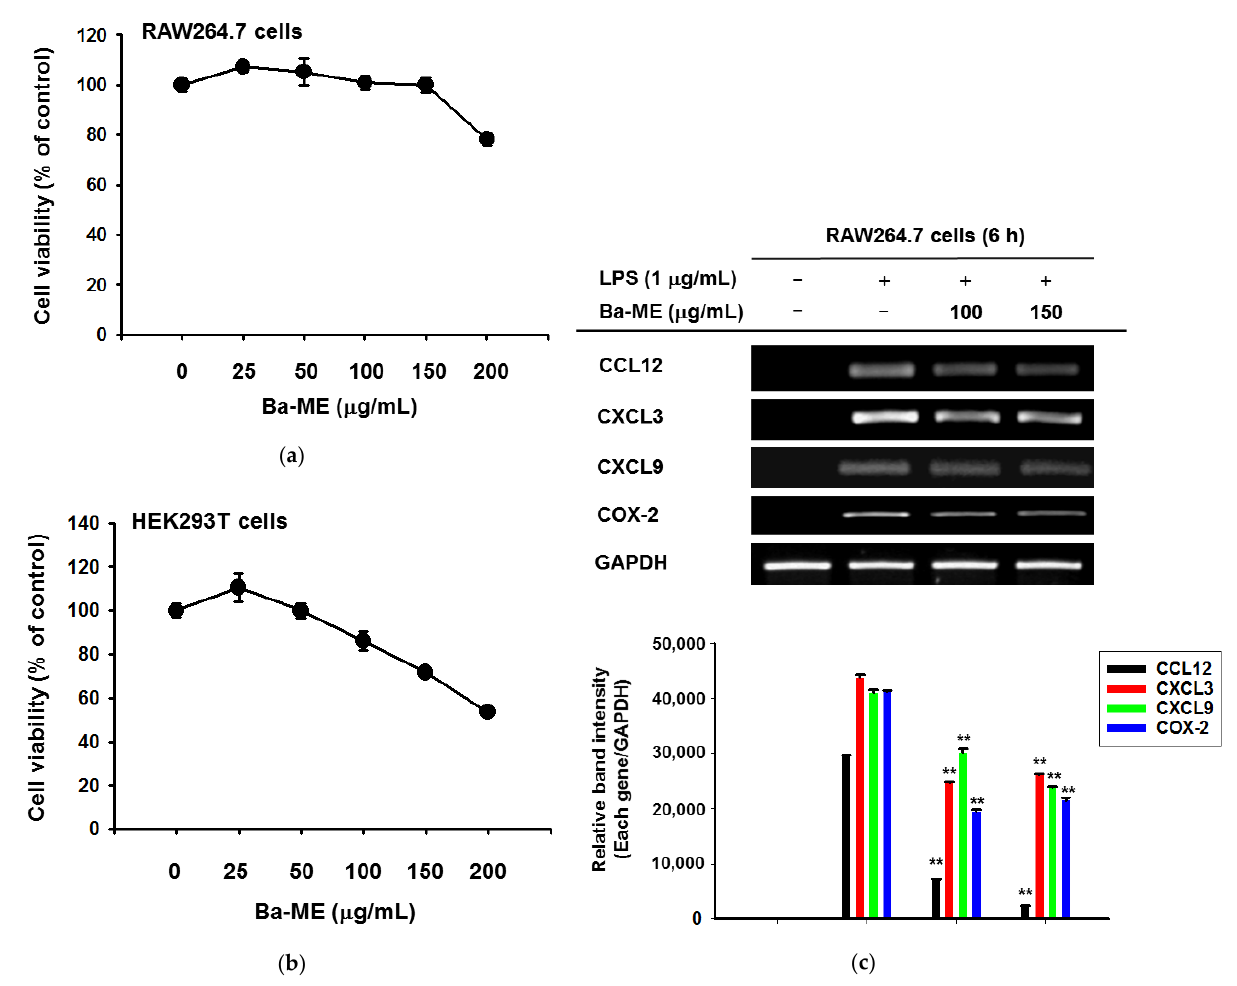
Figure 1. Effects of Ba-ME on cell viability and inflammatory gene expression in LPS-treated cells. ( a ) Treated RAW264.7 cells with Ba-ME with the indicated concentrations for 24 h. Used MTT assay to measure the cell viability. The values are presented as mean ± SD of 3 replicates. ( b ) HEK293T cells were treated with different Ba-ME concentrations for 24 h, and the MTT assay was performed to determine cell viability. The values are presented as mean ± SD of 3 replicates. ( c ) Employing RT-PCR to detect the mRNA expression levels of CCL12, CXCL3, CXCL9, COX-2, and GAPDH in LPS-stimulated RAW264.7 cells treated with Ba-ME (0–50 µ g/mL). Band intensity (the bottom panel of ( c )) was measured and quantified using ImageJ. ** p < 0.01 compared with control